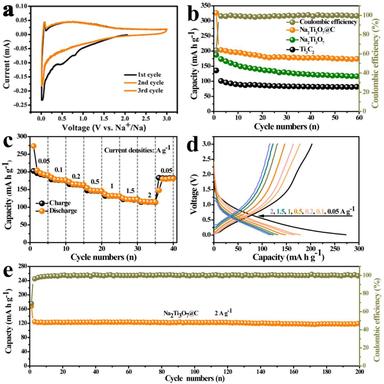
Electrochemical measurements of the Na2Ti3O7@C composite in sodium ion batteries. (a) Cyclic voltammetry curves at a scan rate of 0.1 mV s−1 . (b) Cycling performances of Na2Ti3O7@C composite, pristine Na2Ti3O7 and pure Ti3C2Tix at 0.2 A g−1 . (c and d) Rate performance and corresponding charge/discharge curves. (e) Long cycling performance and corresponding coulombic efficiency of the Na2Ti3O7@C electrode at 2 A g−1 .